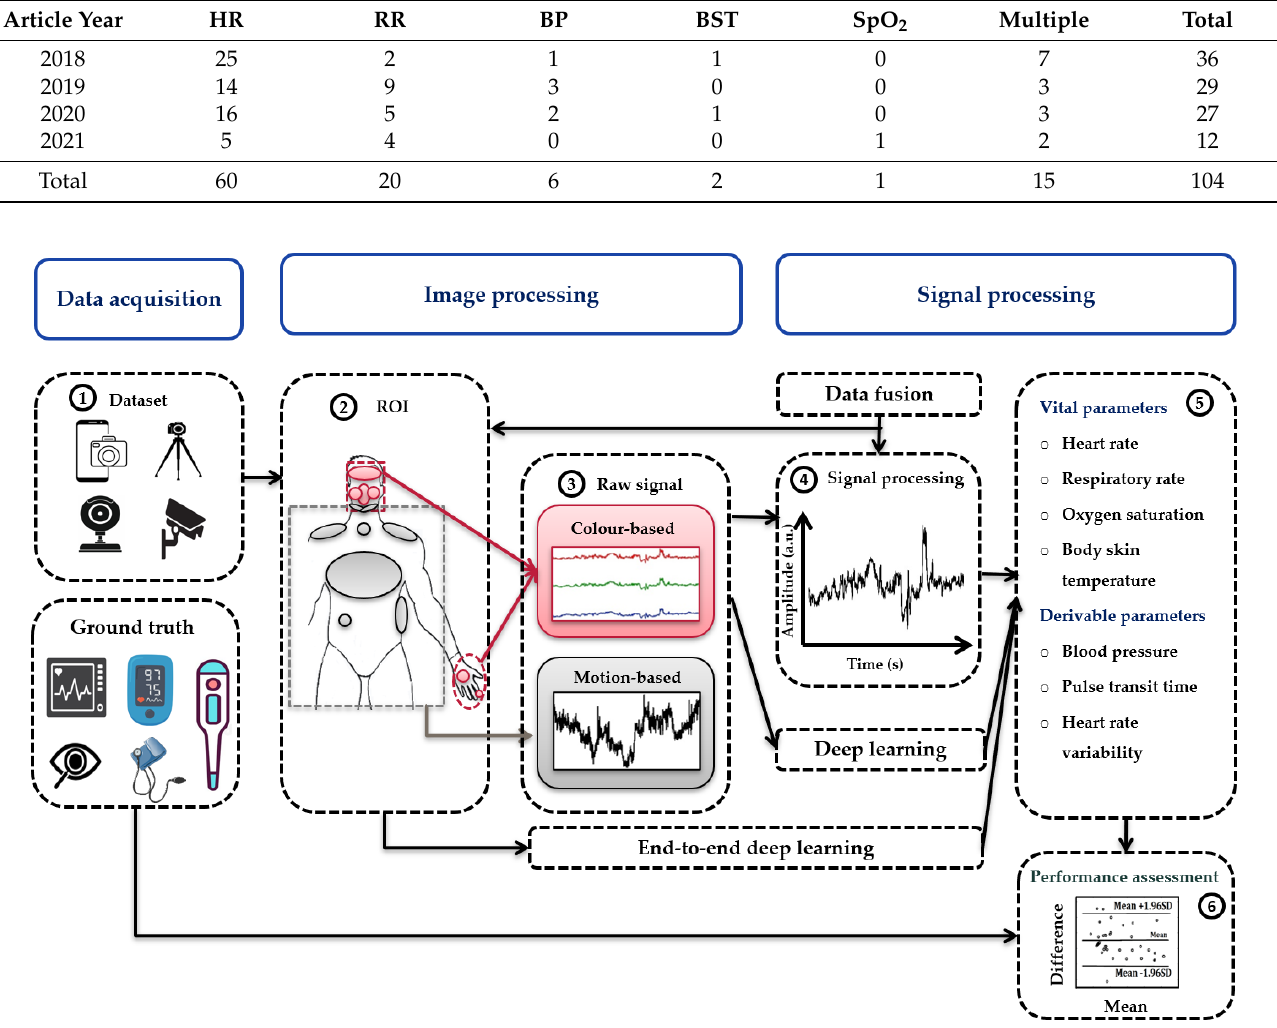
Table 1. Number n of articles from the considered years: January 2018 to April 2021.